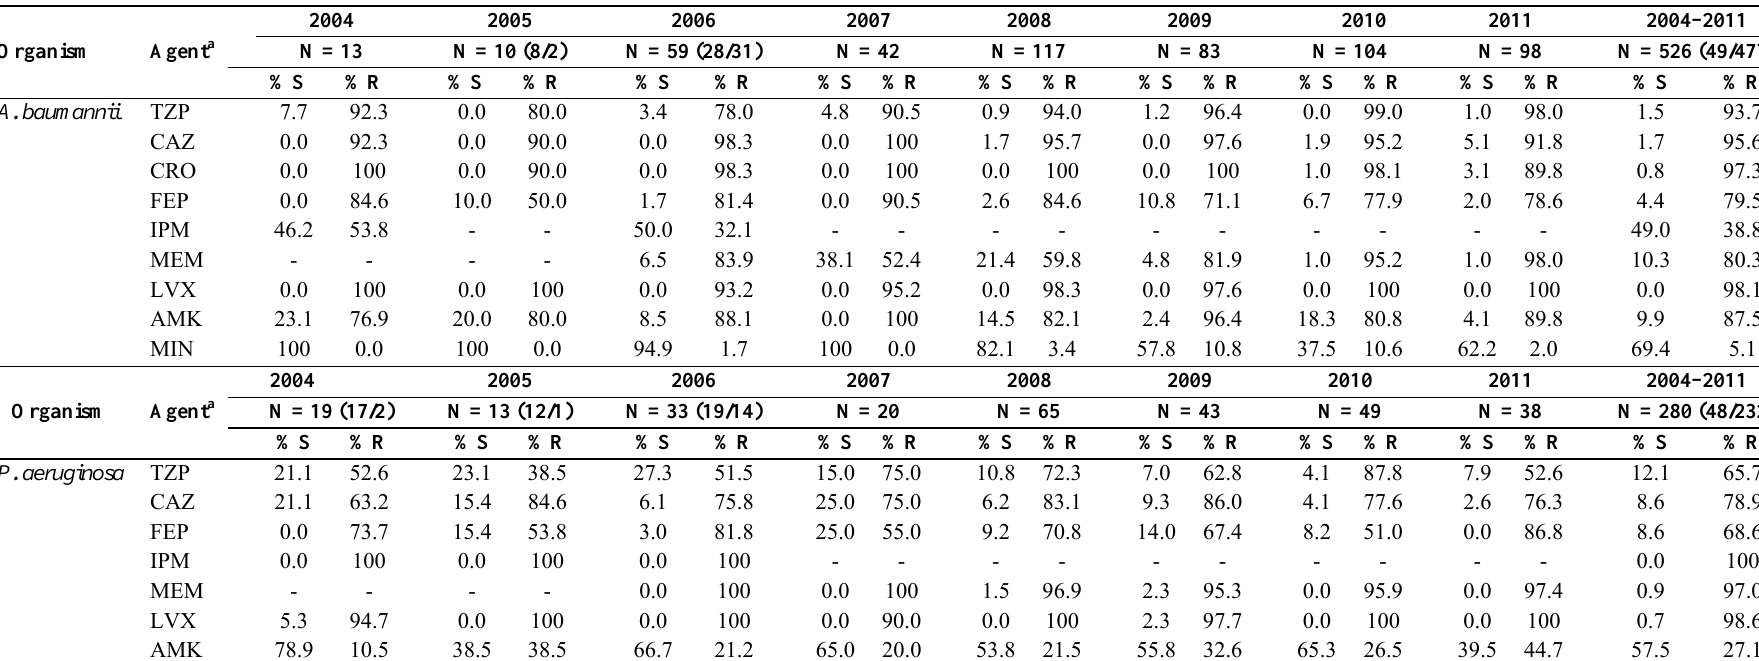
Table 4. Overall prevalence (N), susceptibility (%S) and resistance (%R) among multidrug-resistant isolates of A. baumannii and P. aeruginosa collected in Italy during T.E.S.T.